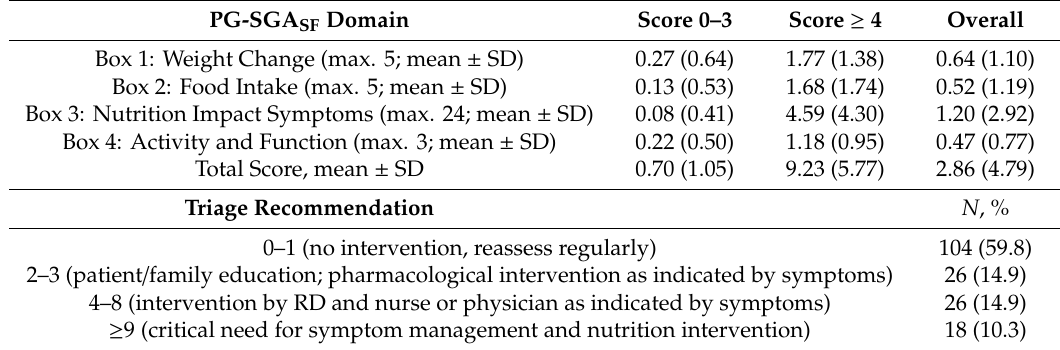
Table3. Patient-GeneratedSubjectiveGlobalAssessmentShortFormscoresandtriagerecommendation.